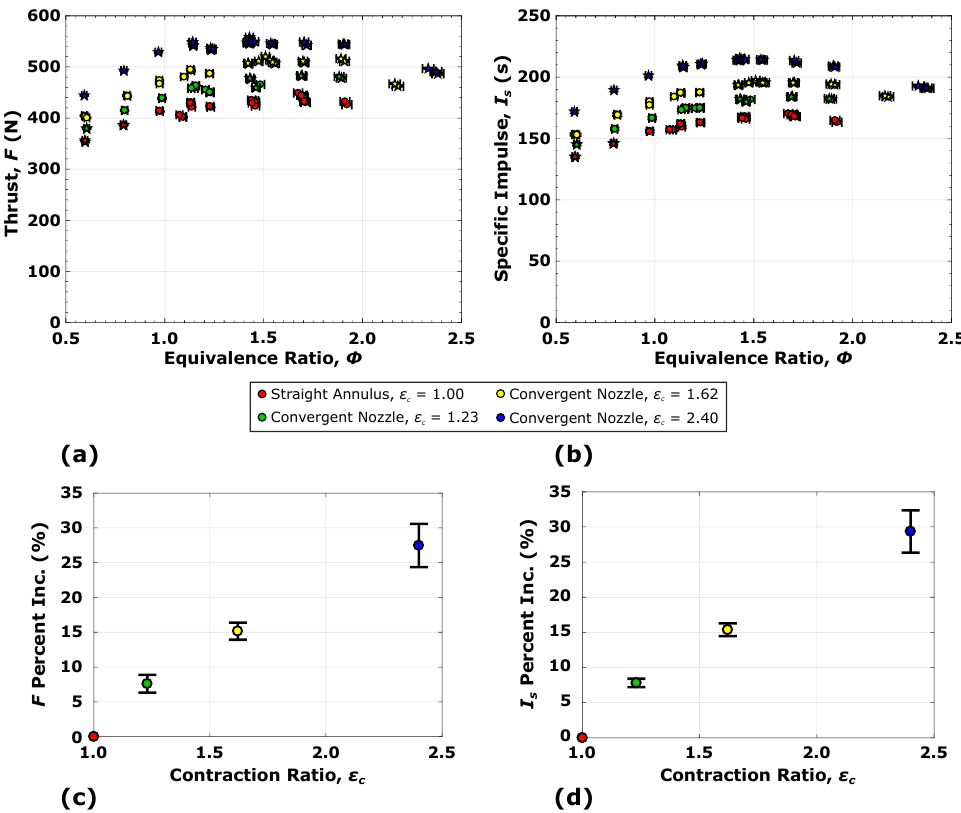
Figure 5. Performance summary for the l c = 76.2 mm convergent nozzle study showing ( a ) thrust F and ( b ) specific impulse I s for the equivalence ratio flow conditions at ˙ m tot = 0.272 kg/s, as well as average percent increase for ( c ) F and ( d ) I s as a function of contraction ratio (cid:101) c across these conditions. Depending on the flow condition and convergent nozzle geometry, the engine